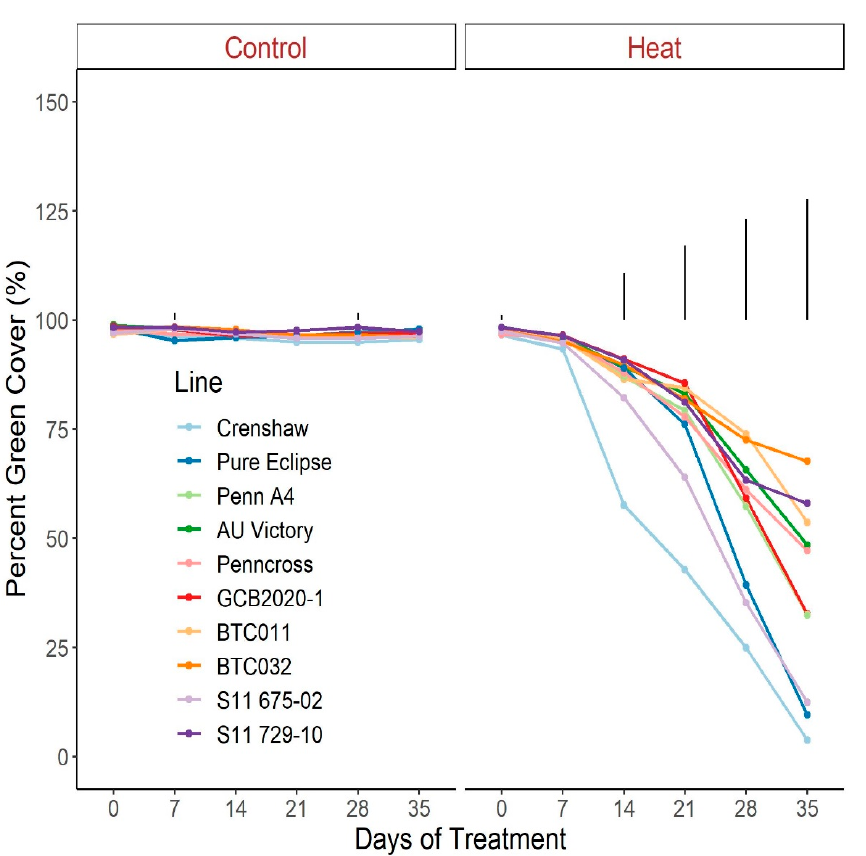
Figure 2. Change in percent green cover for creeping bentgrass lines over time under control (20/15 °C day/night) and heat stress (38/33 °C day/night) conditions. Bars represent LSD values at p = 0.05 on days when significant differences among lines were found.